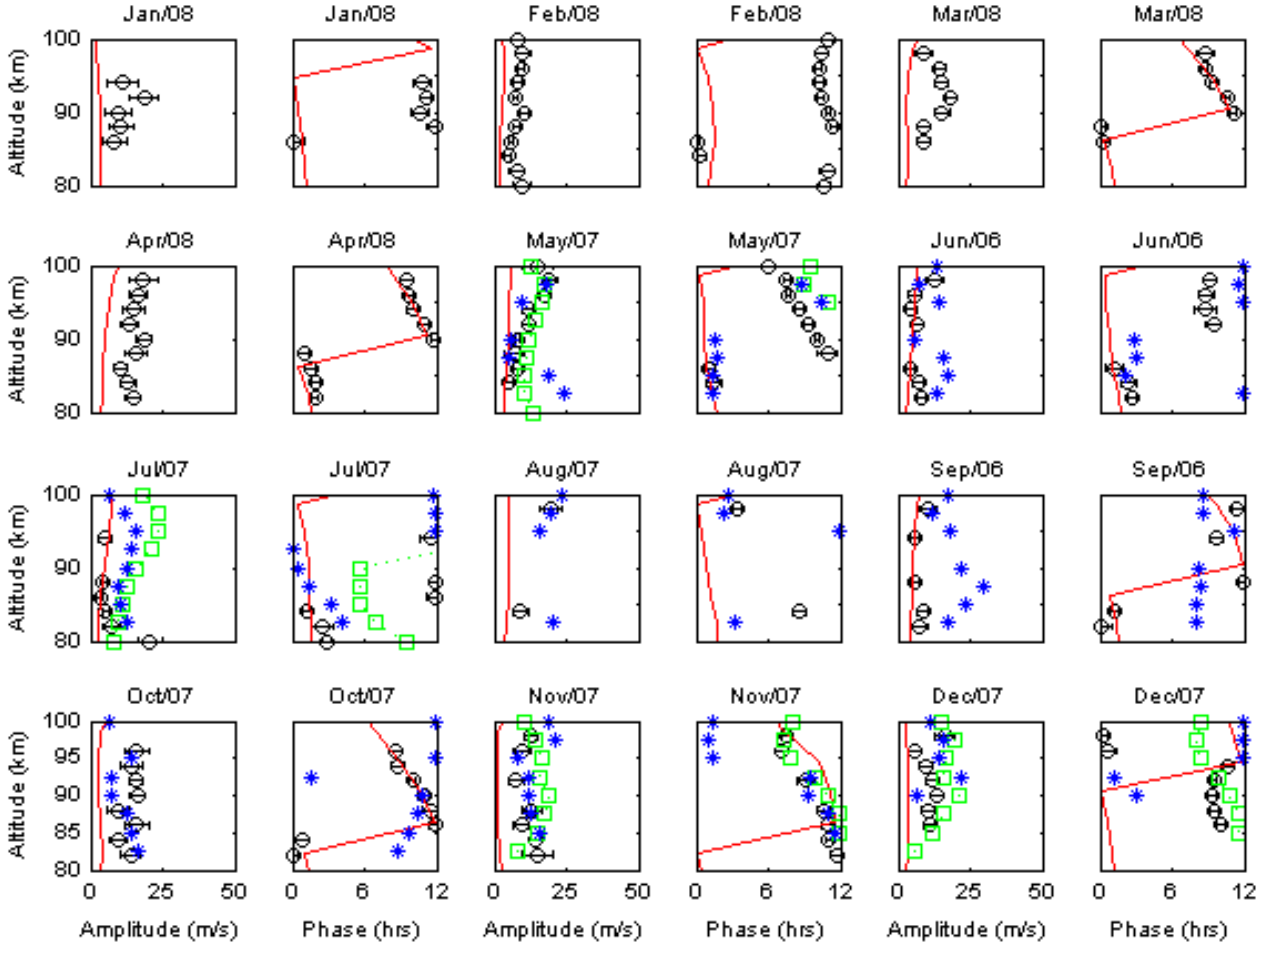
Fig. 3. Same as Fig. 2, but for meridional diurnal